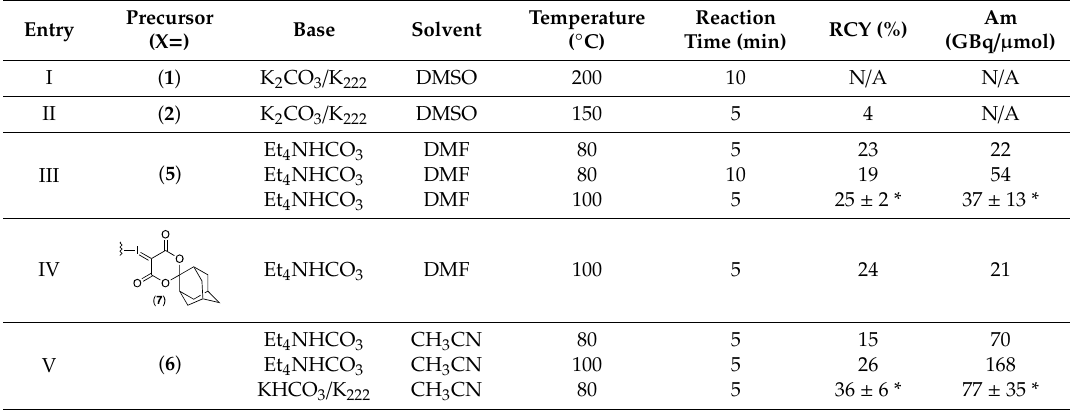
Table 2. Summary of automated radiosyntheses of [ 18 F]FPEB (this work).